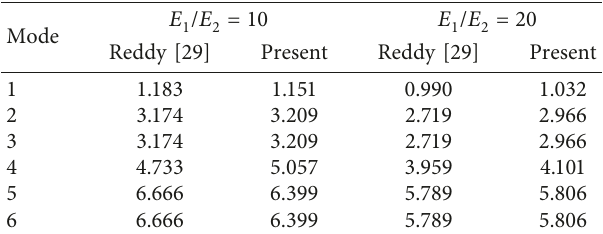
Table 8: Comparison of the nondimensional frequencies 􏽥 ω a square SSSS composite